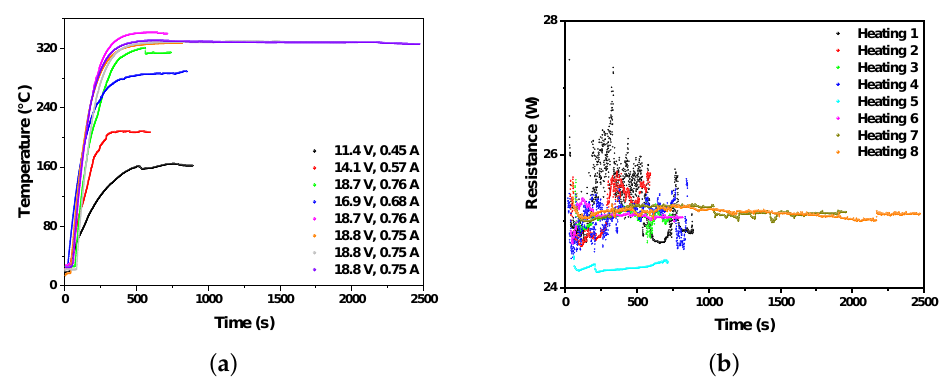
Figure 12. ( a ) CuITF heating curves as a function of time for different values of current and voltage, using an electrical resistance of 25 Ω ; and ( b ) variation of electrical resistance as a function of time for 8 heating